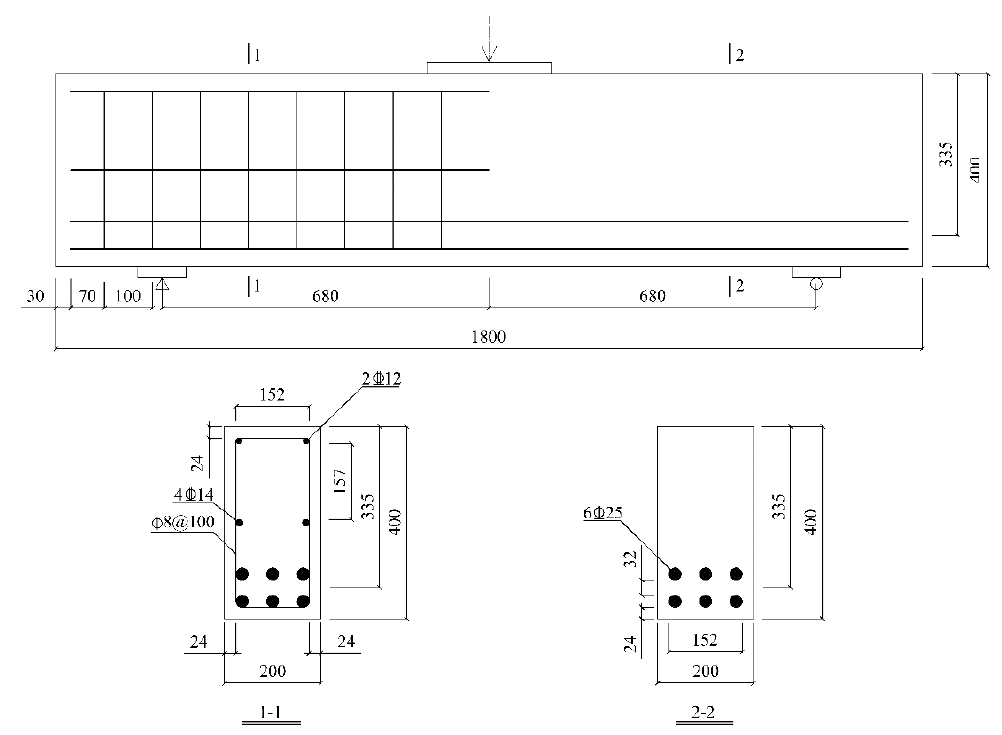
Figure 2. Main structural dimensions of RC beam (unit: mm).